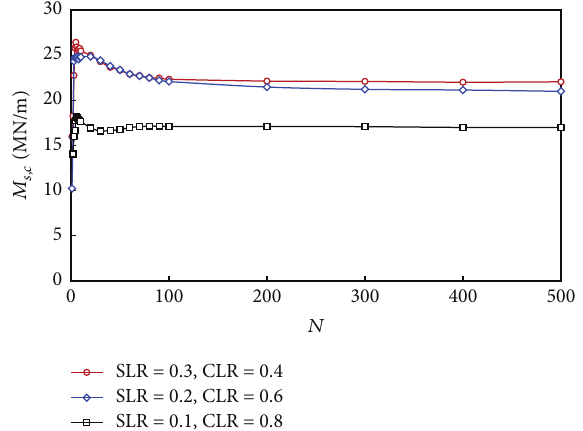
Figure 14: Variation of cyclic secant modulus for different